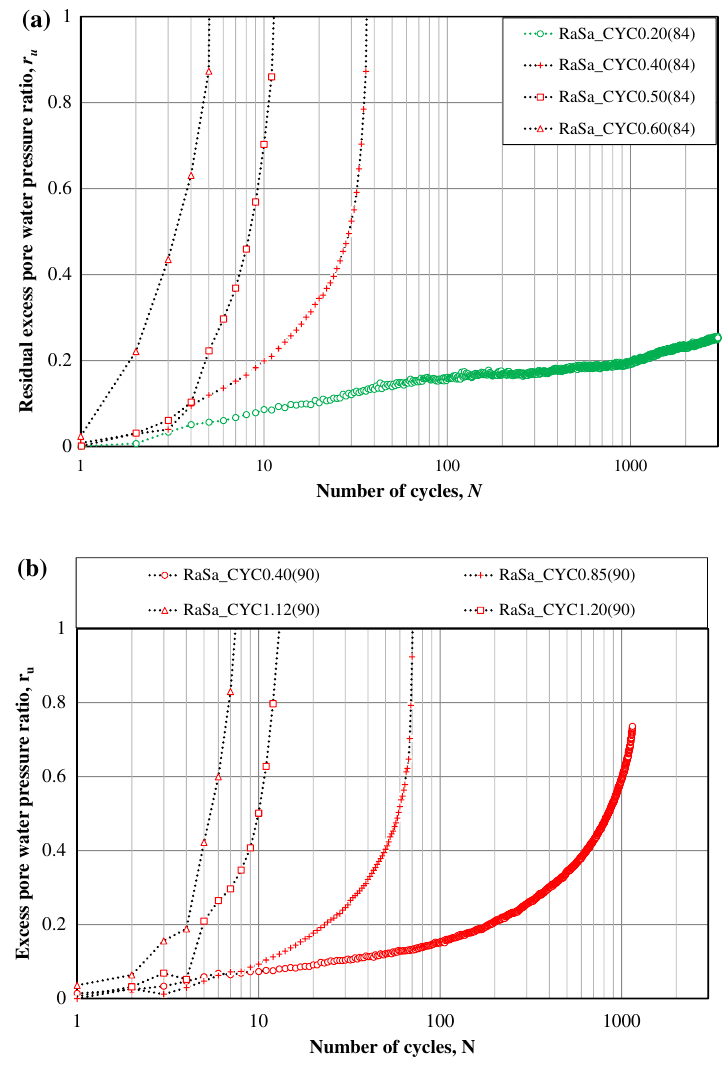
Fig. 7 Excess PWP response under undrained cyclic triaxial loading: a railway sand samples with relative compaction 84%; b railway sand samples with relative compaction